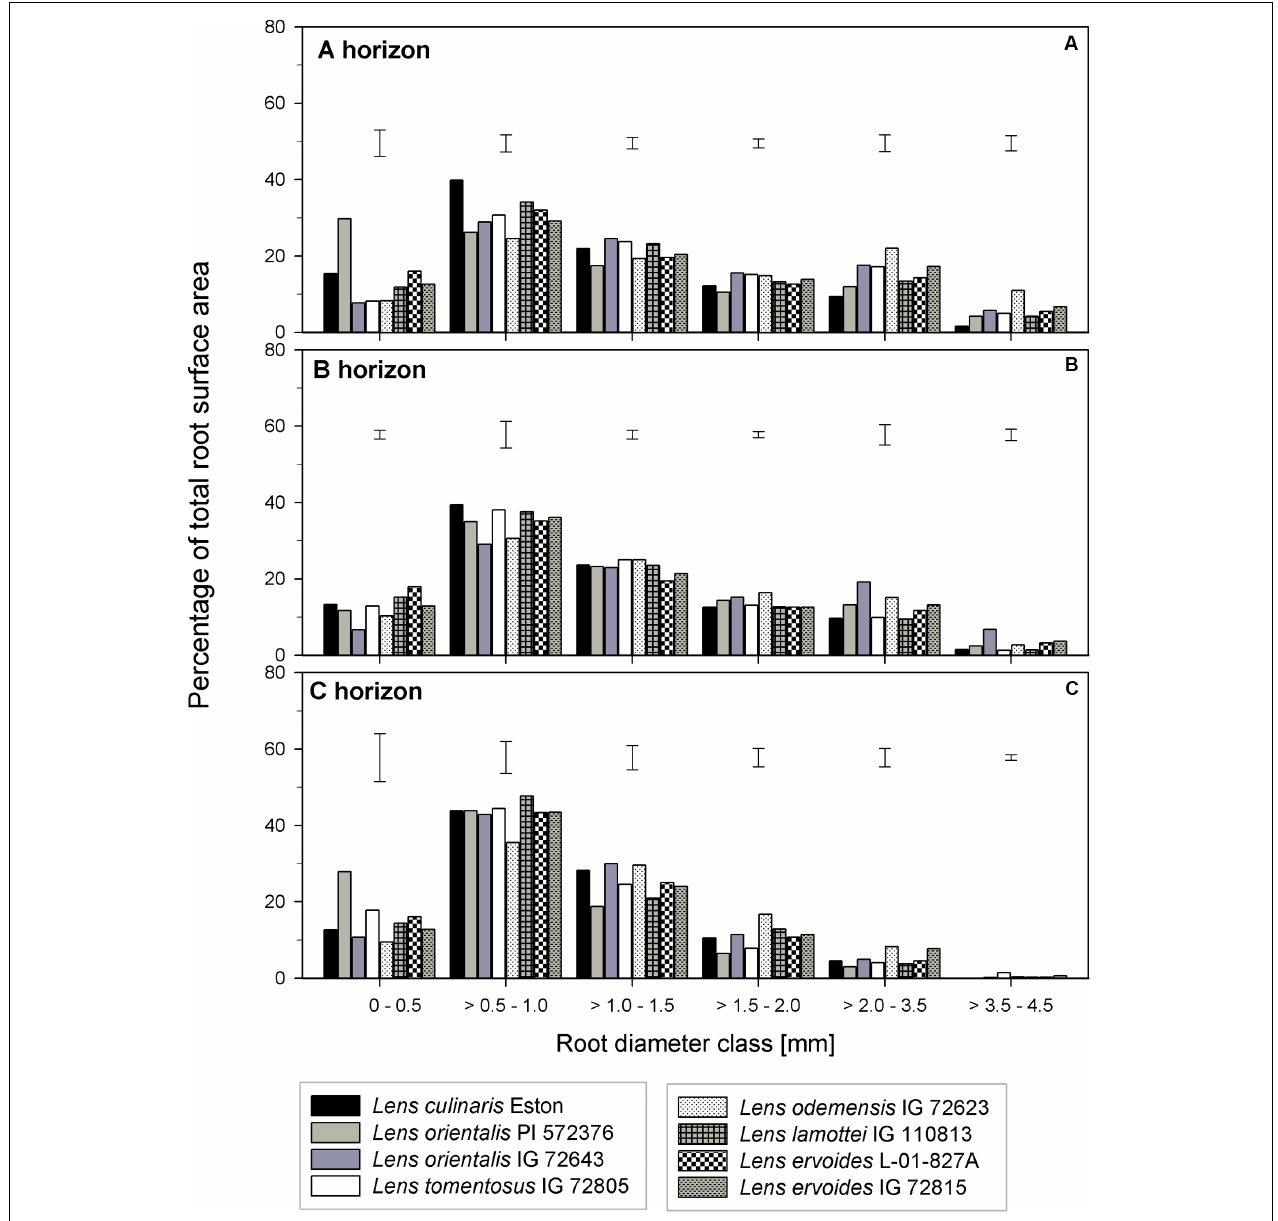
FIGURE 5 | Percentage of total root surface area distribution for six root diameter classes in three soil horizons for seven wild lentil genotypes in comparison to cultivated lentil ( Lens culinaris Eston). The line bars are LSD values at P < 0.05 for comparison of genotypes within a diameter class. (A) A horizon; (B) B horizon; (C) C